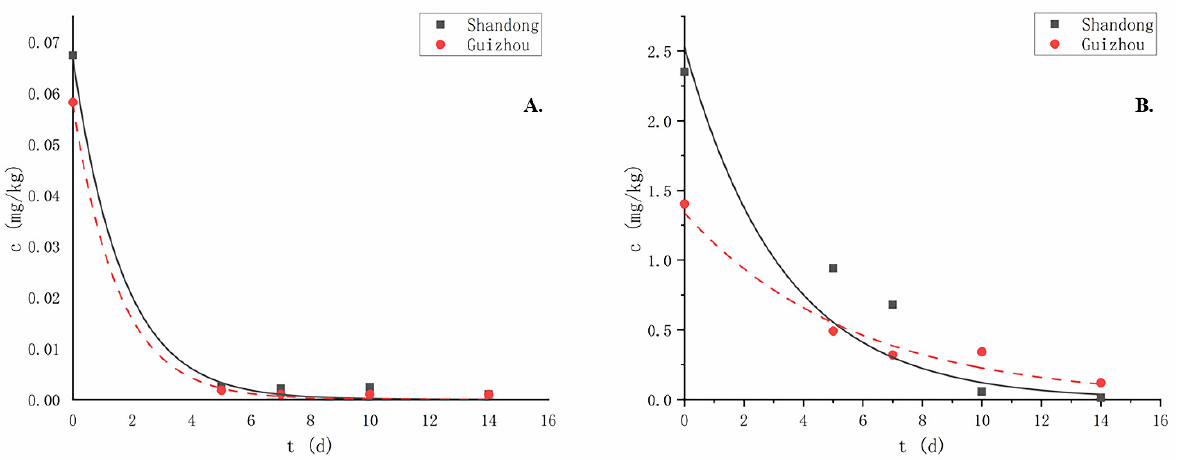
Figure 2. Degradation rates of metalaxyl-M and azoxystrobin in scallion samples in Shandong and Guizhou: ( A ) metalaxyl-M, and ( B ) azoxystrobin.